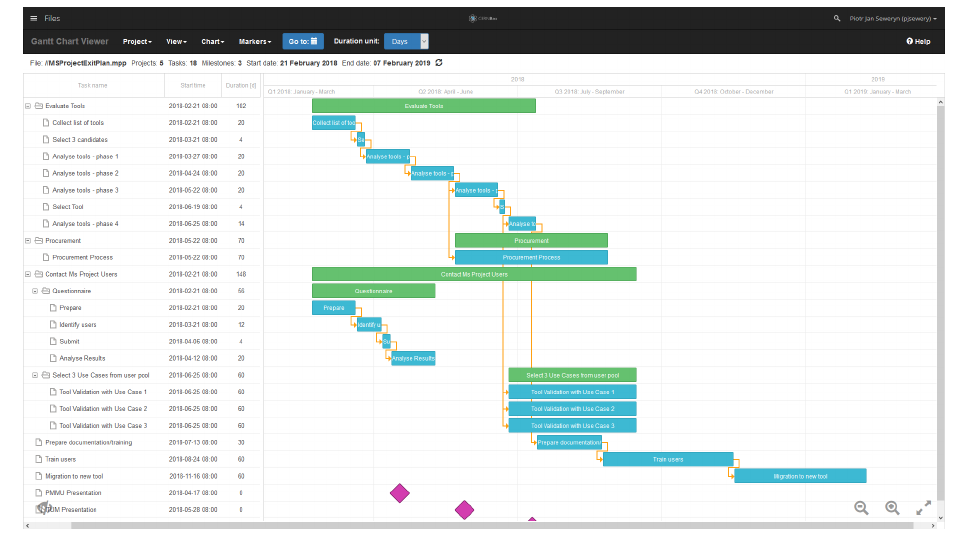
Figure 8. Gantt Chart Viewer application for CERNBox - User